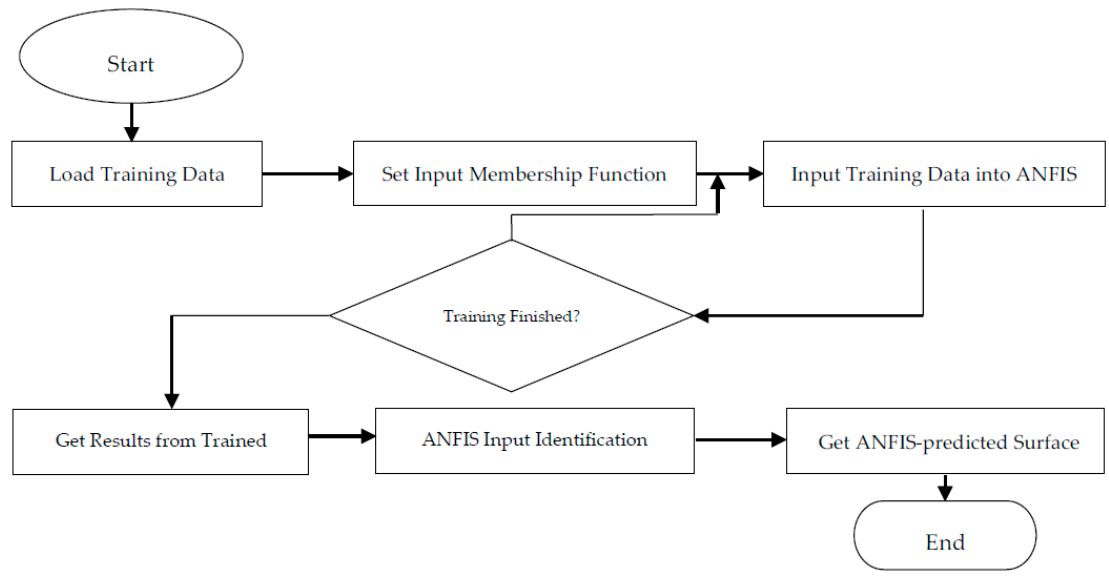
Figure 2. The ANFIS architecture.